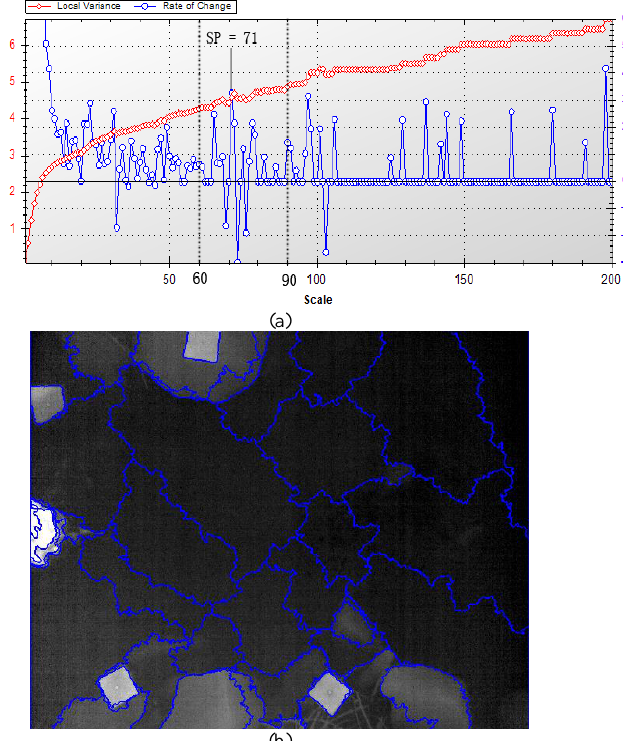
Figure 4. 1st Image Segmentation Result: (a) Best SP Selection (b) Segmentation Result under Best